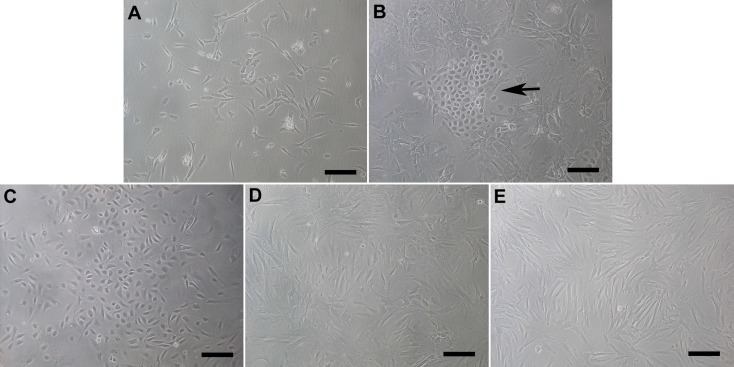
Morphology of ADEPCs, ADSCs and RBSMCs.
(A) Primary cells appeared after culture for 48h. (B) After one-week culture, ADEPCs (black arrow) emerged within spindle-like ADSCs. (C) ADEPCs could be separated from ADSCs according to their different responses to trypsinization. (D) ADSCs were subcultured in a new flask. (E) RBSMCs emerged and exhibited typical spindle-shaped morphology after 5 days culture. Scale bar = 100μm.